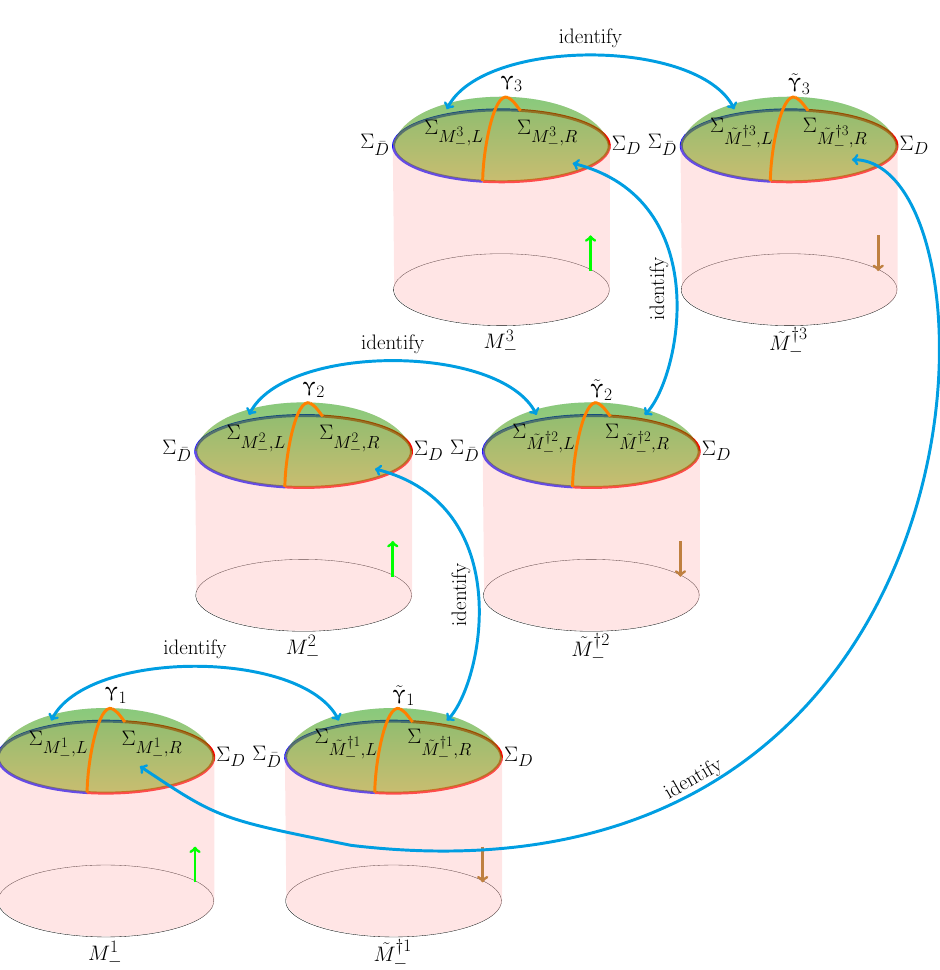
Figure 2 . A typical bulk configuration of the gravitational path integral that computes Tr[( ρ ( D )) n ] for n = 3